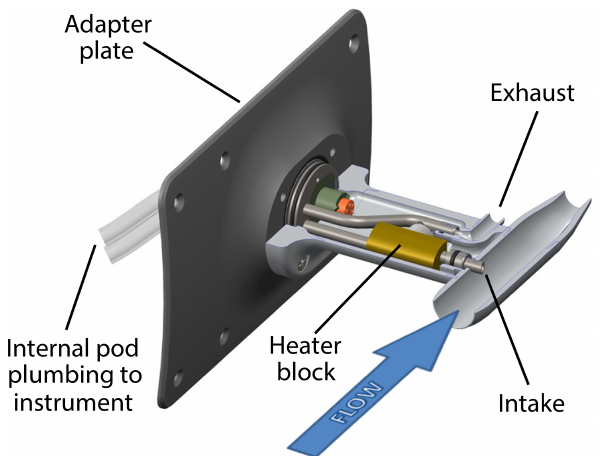
Figure 4. A cross-sectional view of the CAFE inlet used on the NASA ER-2. Ram pressure is created by ambient air entering a na- celle mounted on the end of an air foil. Sample air is drawn toward the instrument through a heated Silcosteel tube that protrudes into the nacelle perpendicular to the ambient air flow. Internal to the pod, 1.3m of tubing delivers the sample flow to the instrument and an equal amount returns the exhaust flow to the inlet where it is directed out the back of the air